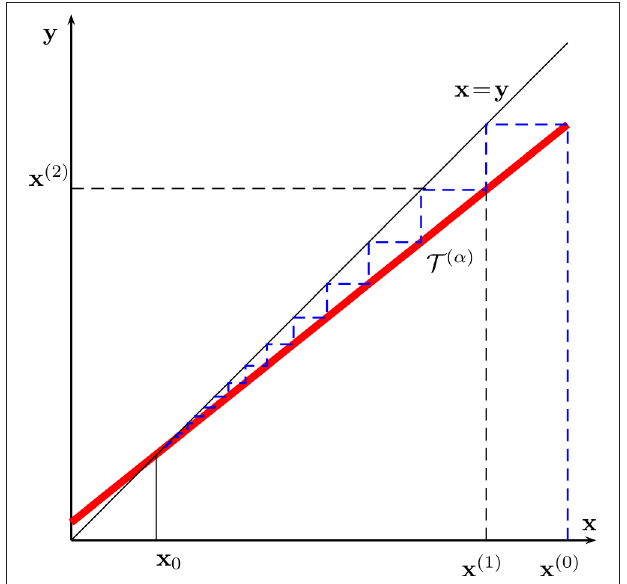
FIGURE 1 | Fixed-point iterations for a contractive mapping T ( α ) with the unique fixed point x 0 .